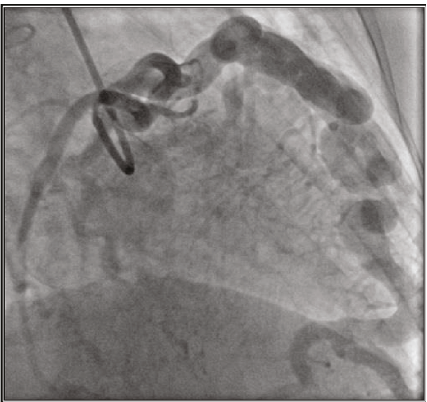
Figure 3: Invasive angiography revealing ectatic/aneurysmal